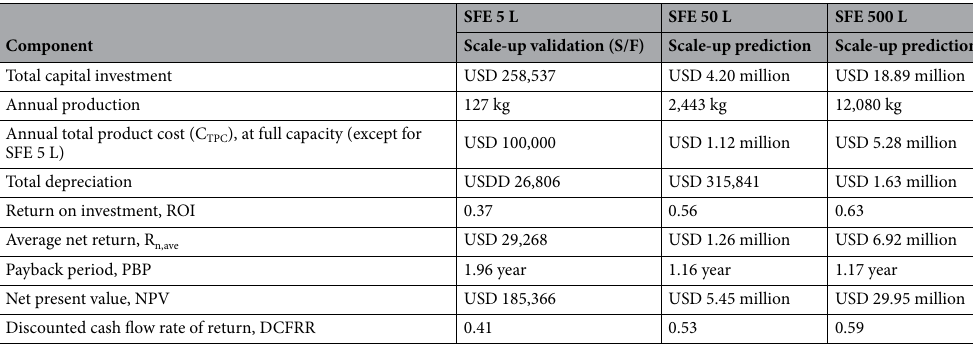
Table 13. Summary of economic analysis of different SFE system for L2 operating